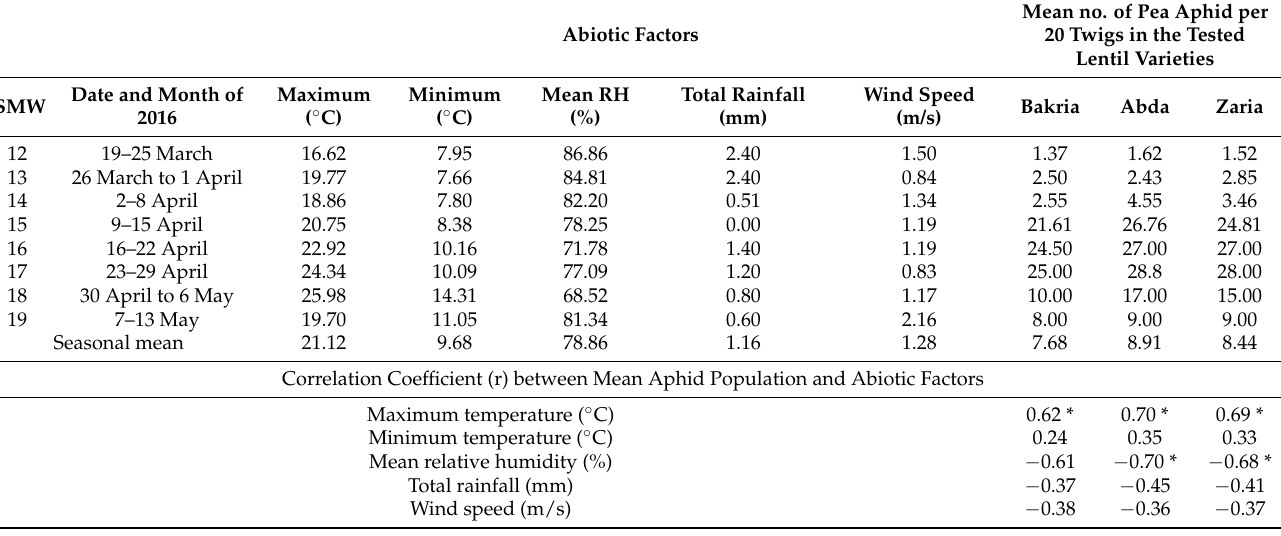
Table 5. Influence of weather factors on mean number of pea aphid, A. pisum , per 20 twigs of three lentil varieties during 2015–2016.